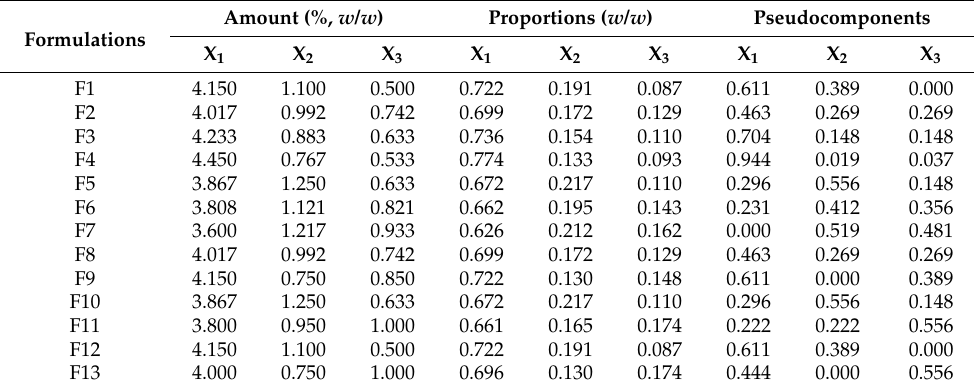
Table 6. Planning of ternary mixture of NLC containing Palmarosa essential oil.